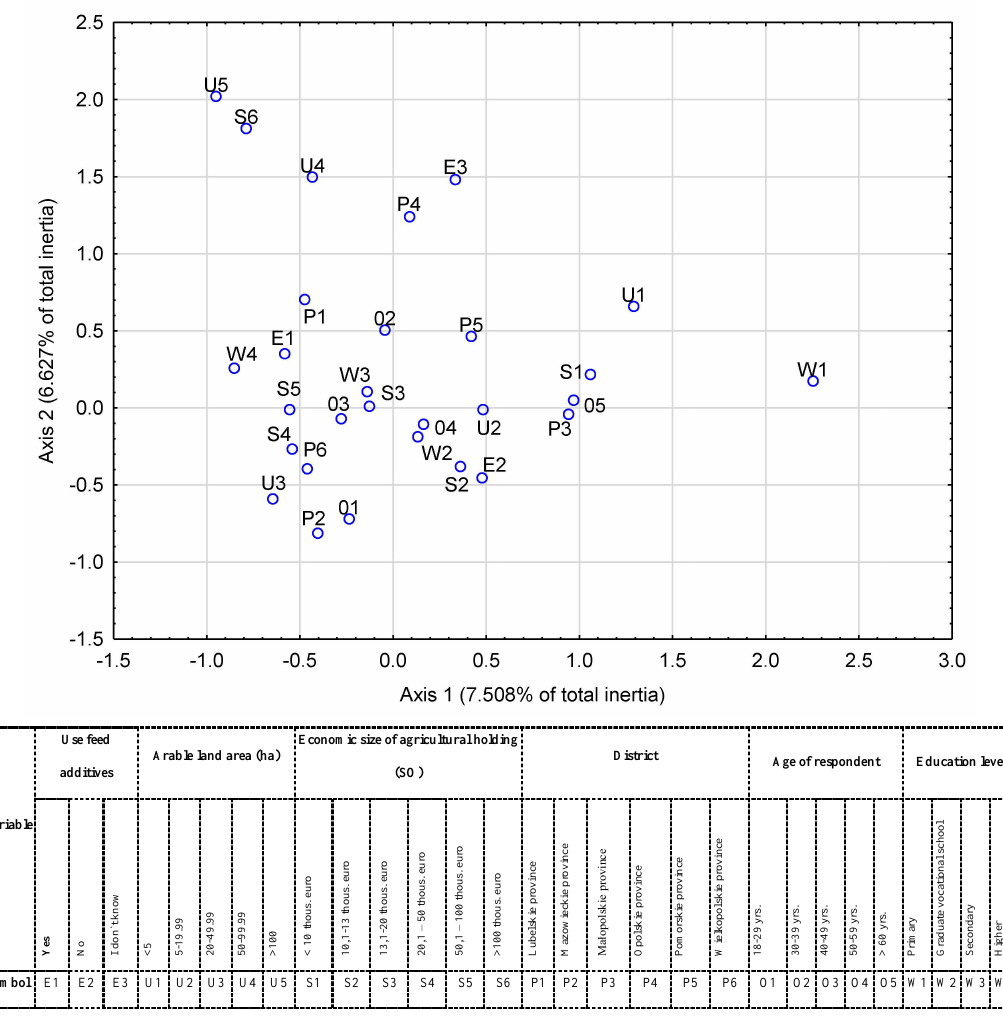
Figure 5. Graphical presentation of the results of the correspondence analysis between the declarations of using appropriately selected feed additives with the tested characteristics of farmers and farms. Source: own study based on questionnaire surveys ( n = 520).